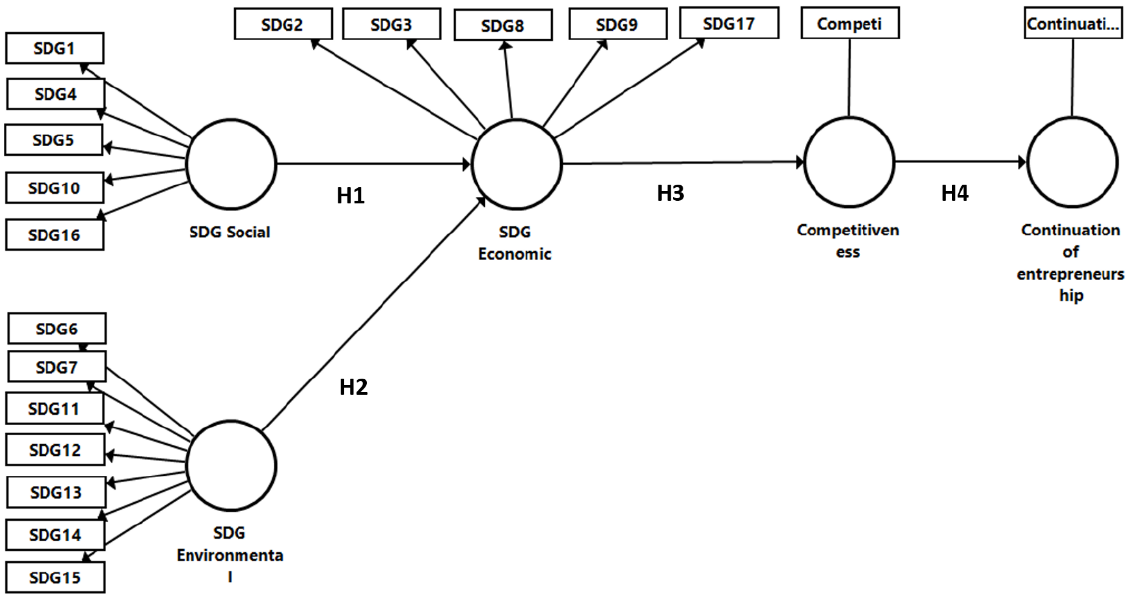
Figure 1. Research model to be tested .